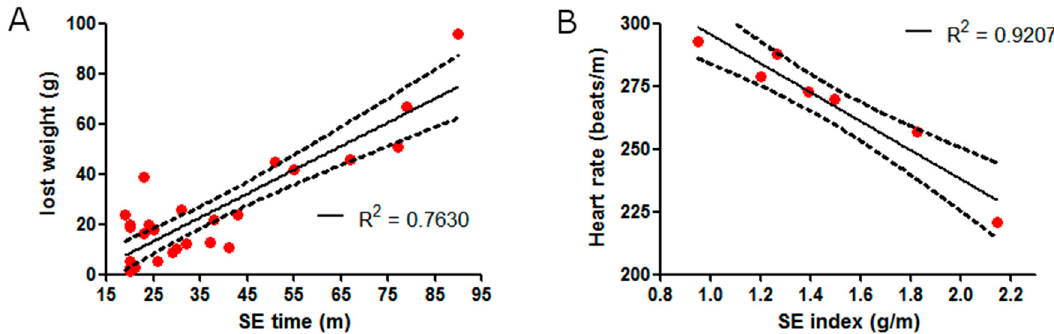
Figure 1. Strength of single Status Epilepticus (SE). ( A ) SE strength index. A linear correlation between SE time and lost weight 3 days after SE was observed. Note that the survival of the rats decreased with longer SE time. ( B ) Inverse correlation between SE strength index and heart rate variation is observed. The correlation’s coefficient (R 2 ) and the confidence interval (dashed line) are showed in both graphics.